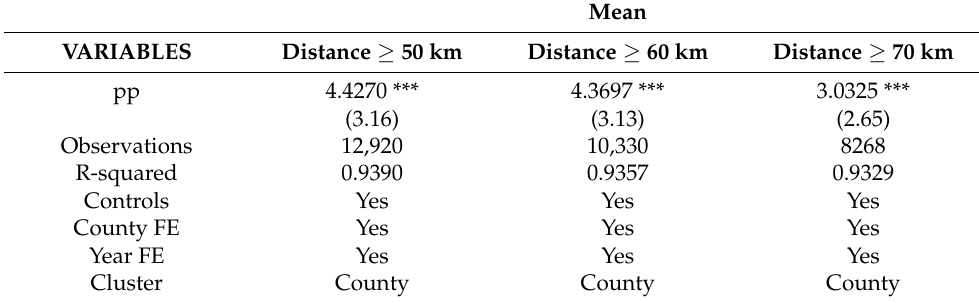
Table 5. Spillover effect